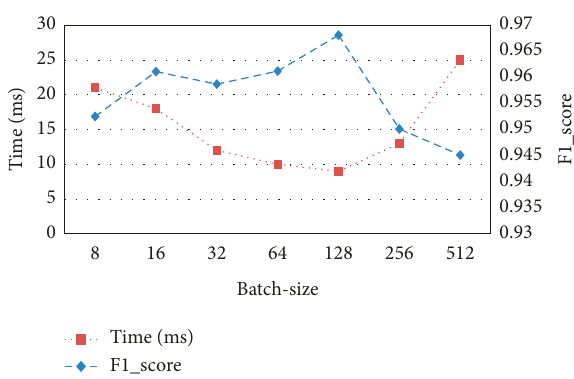
Figure 17: Performance of the model under different batch